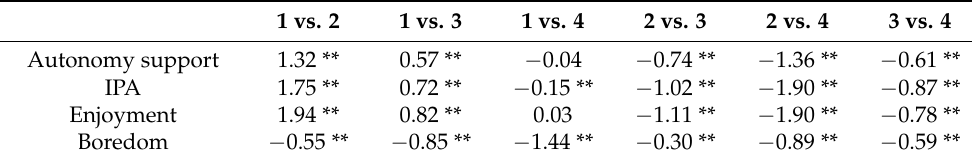
Table 4. Contrast of multiple comparisons according to Z values.